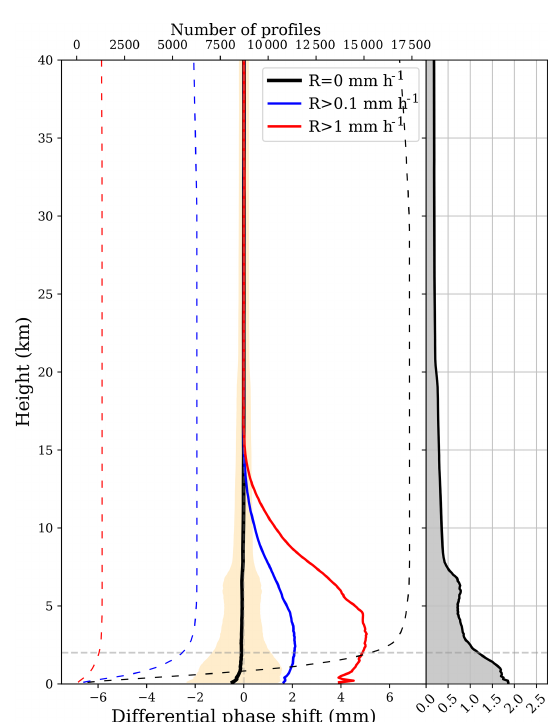
Figure 10. Mean (solid black line) and standard deviation (orange shaded) of (cid:49)(cid:56)(h 100m ) as a function of height for the PRO events collected under no rain conditions. The solid blue and red lines show the mean of (cid:49)(cid:56)(h 100m ) as a function of height for the PRO events collected under R > 0 . 1 and R > 1mmh − 1 , respectively. The dashed lines show the number of collected profiles (top axis) as a function of height corresponding to each group (no precipitation, R > 0 . 1 and R > 1mmh − 1 ). The right side panel shows a more de- tailed vertical profile of the standard deviation σ (cid:49)(cid:56) (h) for the PRO events collected under no rain conditions (gray shaded area). The dashed gray horizontal line indicates the 2km altitude.